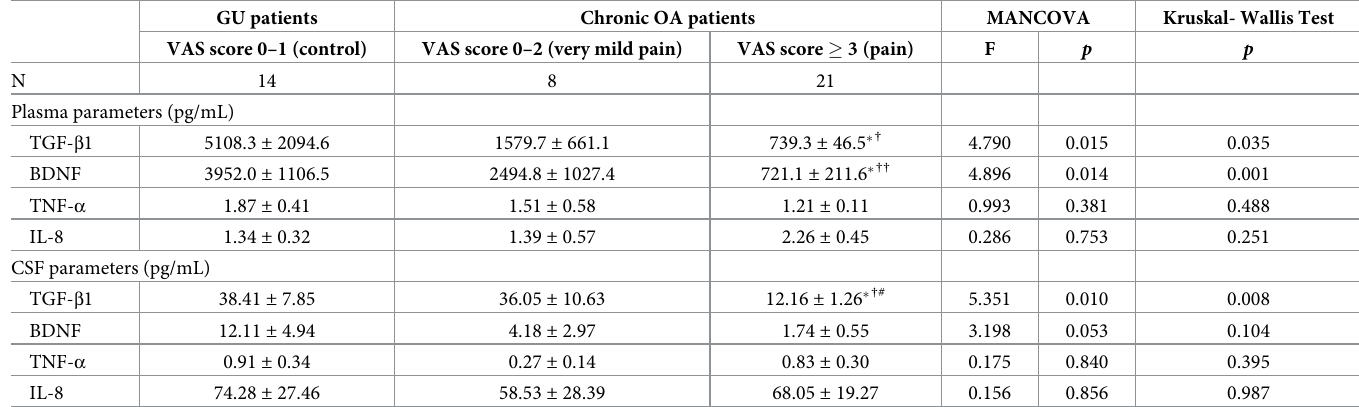
Table 2. Comparison of laboratory parameters in GU and chronic osteoarthritis patients. GU